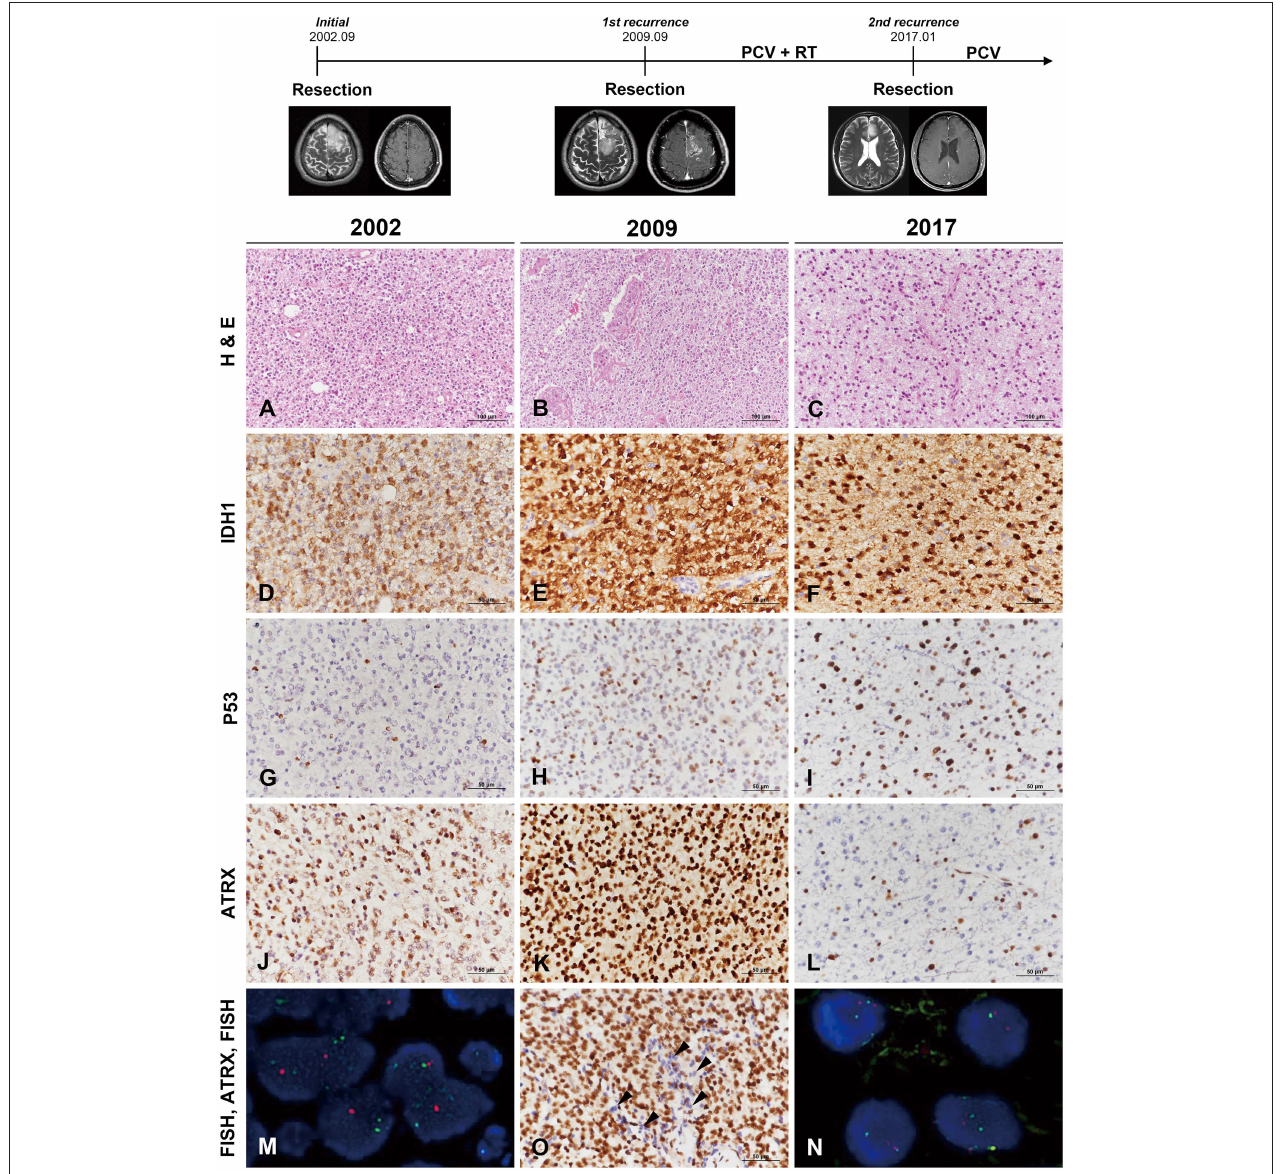
FIGURE 1 | Clinicoradiological and pathological findings in case 1. The clinical progression of case 1 is summarized in uppermost. In 2002, the lesion was composed of round monotonous tumor cells with perinuclear halos (A) and showed increased cellularity with microvascular proliferation in 2009 (B) . The most recent tumor, in 2017, displayed relatively low cellularity but increased cytological atypia (C) ( A–C , hematoxylin and eosin staining; original magnification, × 200). The tumor cells showed well-preserved IDH1-R132H positivity at each recurrence (D–F) , and P53 staining intensity became stronger with further recurrences (G–I) . In comparison, ATRX expression was well-maintained according to two earlier biopsies (J,K) but was lost in the recent recurrence episode (L) . Interestingly, the specimen in 2009 demonstrated strong ATRX expression but also contained tumor cells showing loss of ATRX expression in small areas ( O , arrowheads) ( D–L,O , IHC results; original magnification, × 400). Chromosome 1 FISH performed on the 2002 specimen demonstrated loss of 1p (red) in the tumor cells (M) . Chromosome 19 FISH performed on the 2017 specimen demonstrated two copies of 19q (red) and 19p (green) in the tumor cells (N) ( M,N , FISH; original magnification, × 1,000).